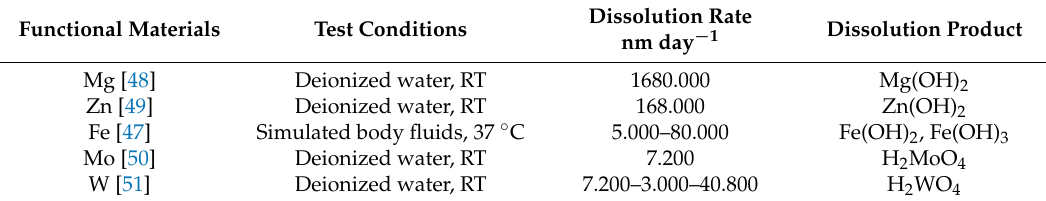
Table 4. Dissolution behavior of metals